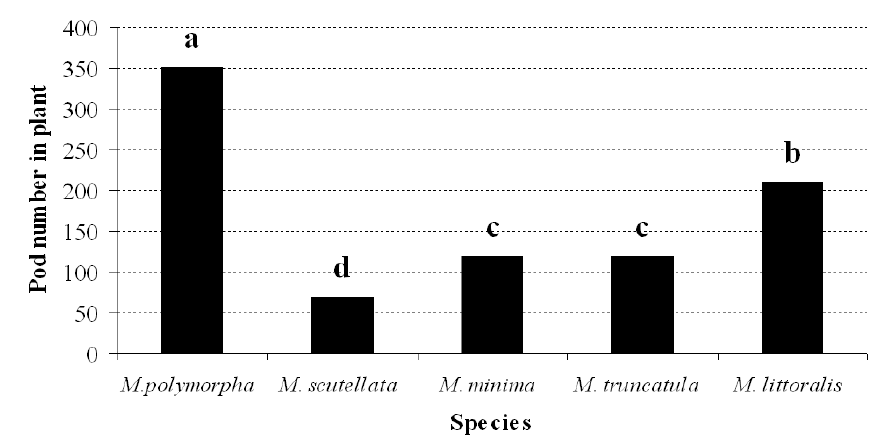
Fig. 7. Main effects of species on pod number in plant. All the values followed by the same letter in each column are not statistically different at the p<0.05 probability level